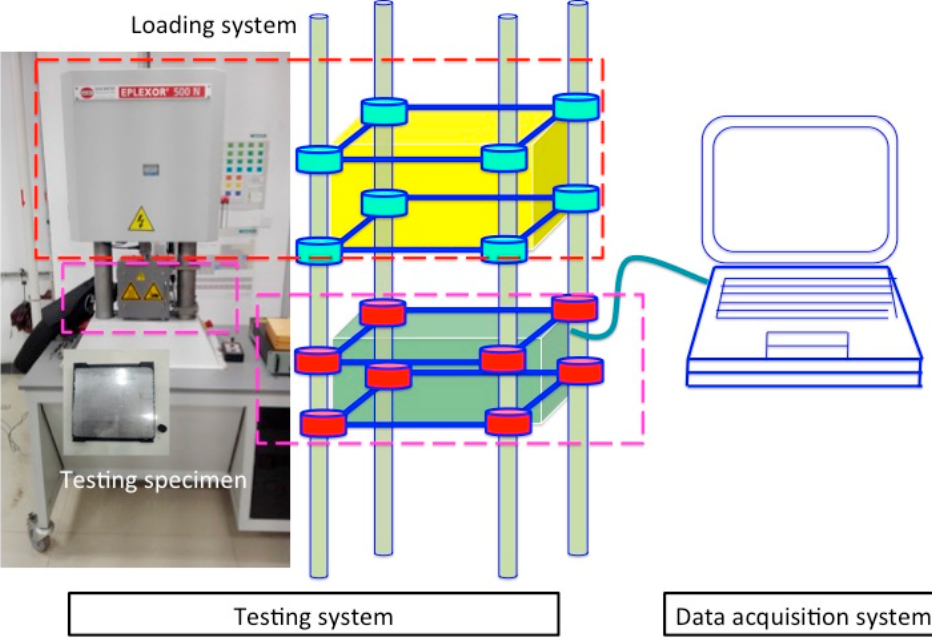
Figure 5. WJ-7B small resistance fastener rubber pad specimen and test equipment.